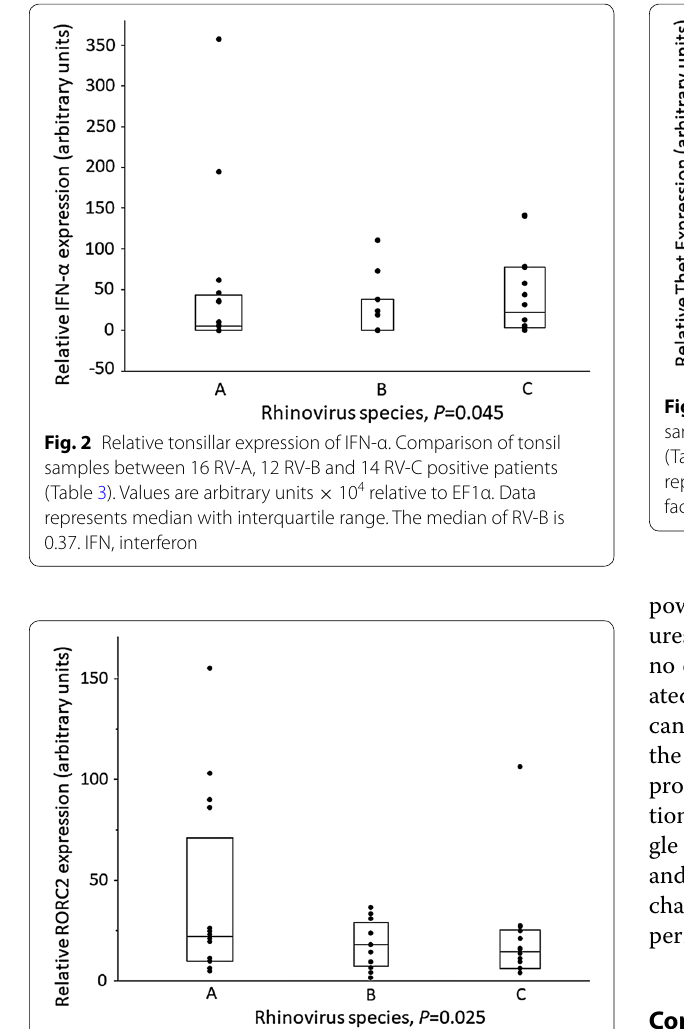
Fig. 3 Relative tonsillar expression of RORC2. Comparison of tonsil samples between 16 RV-A, 12 RV-B and 14 RV-C positive patients (Table 3). Values are arbitrary units 10 4 relative to EF1α. Data × represents median with interquartile range. RORC2, RAR-related orphan receptor C 2